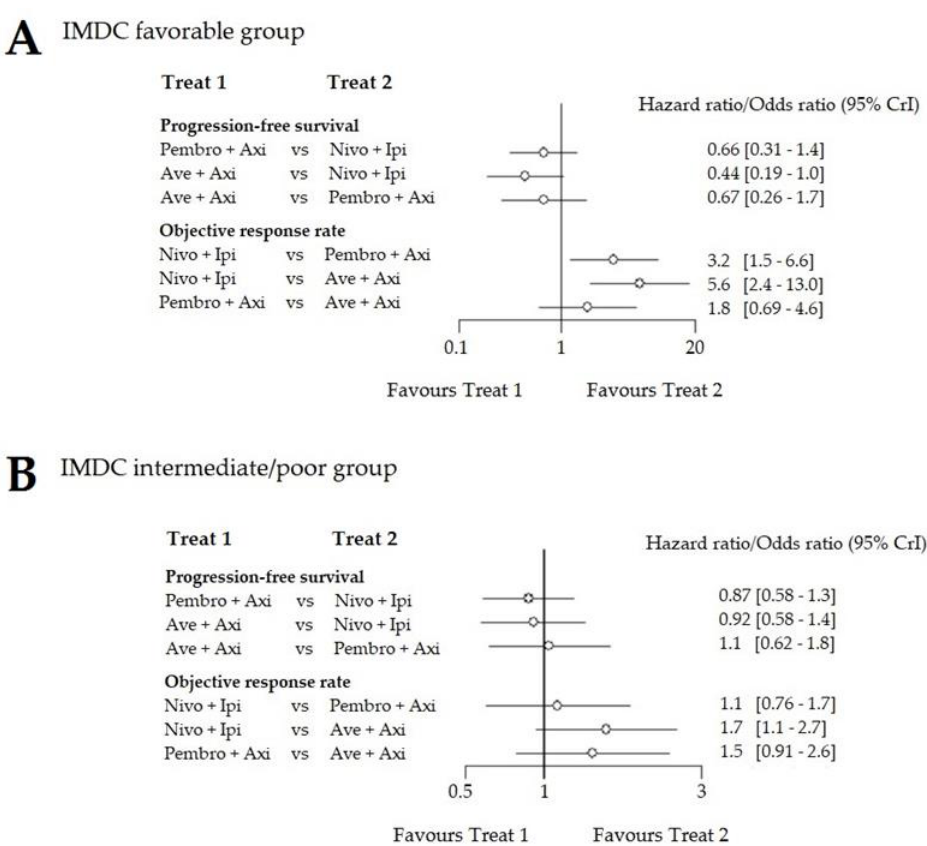
Figure 3. Forest plot of the indirect comparison between each combination. ( A ) results in the IMDC favorable risk group; ( B ) results in the IMDC intermediate and poor (pooled) risk group. For the ORR, the odds ratio favouring treatment 1 (Treat 1) means that treatment 1 had a lower response rate than treatment 2 (Treat 2). Table 2. Summary data in each IMDC subgroup.